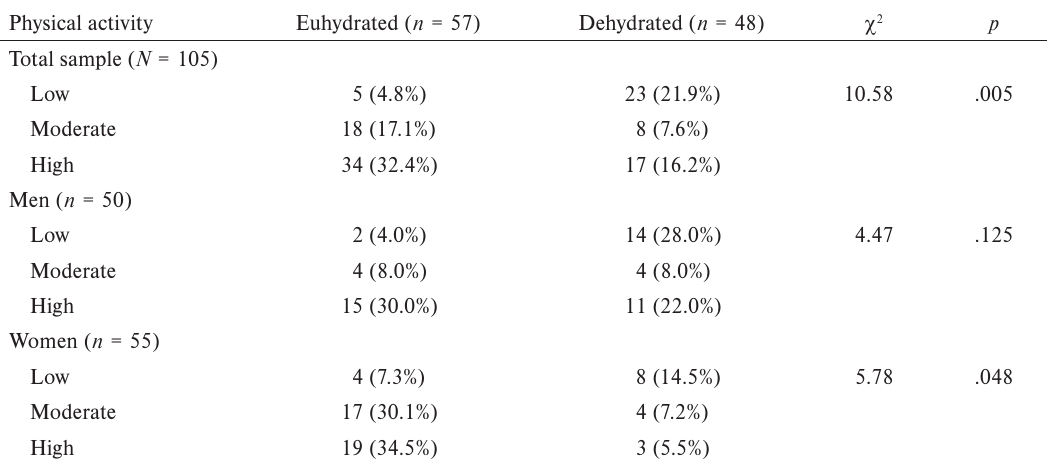
Physical activity level of the participants stratified by hydration